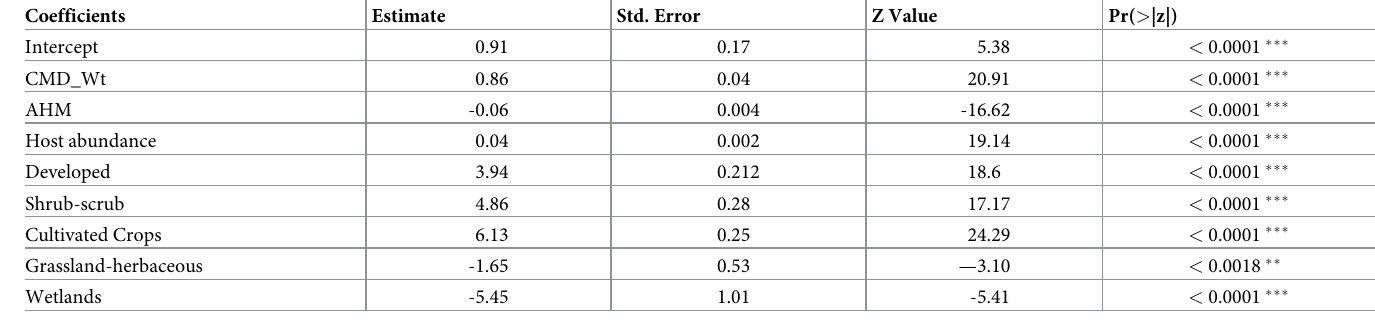
Table 4. GLM model results for R . indifferens . Significant variables include winter Hargreaves climatic moisture deficit (CMD_wt), annual heat-moisture index (AHM), land-cover (developed, shrub-scrub, cultivated crops, grassland-herbaceous, wetlands) and host abundance. Though Hargreaves climatic moisture deficit (CMD),